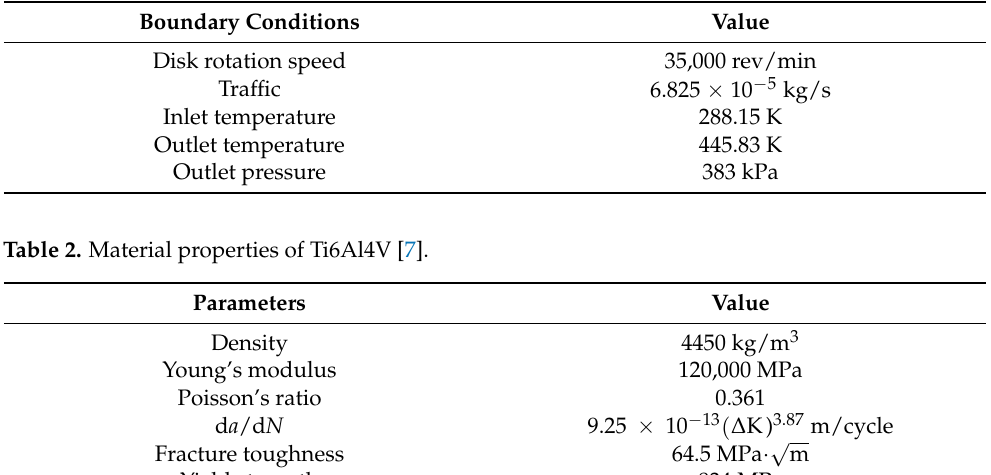
Table 2. Material properties of Ti6Al4V [7].